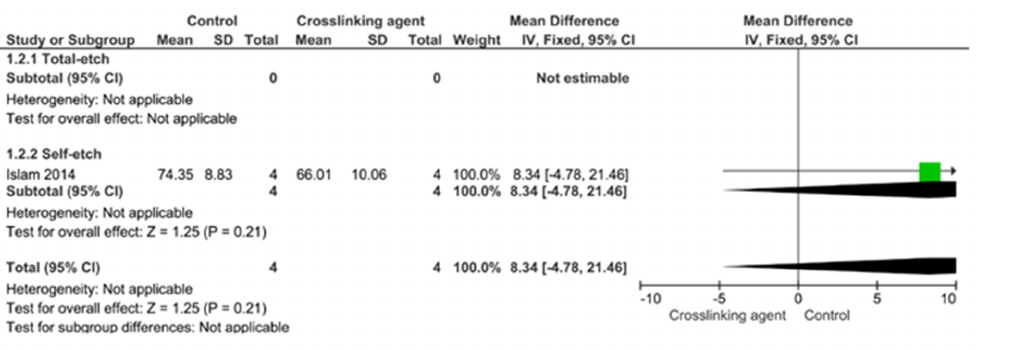
Figure 9. Forest plot of the immediate bond strength comparison between the proanthocyanidins crosslinking agent and the control according to the adhesive used [103]. On the other hand, the incorporation of glutaraldehyde (Figure 10, p = 0.009), riboflavin (Figure 11, p < 0.00001), and EGCG (Figure 12, p < 0.00001) into an adhesive system improved the long-term BS to dentin.